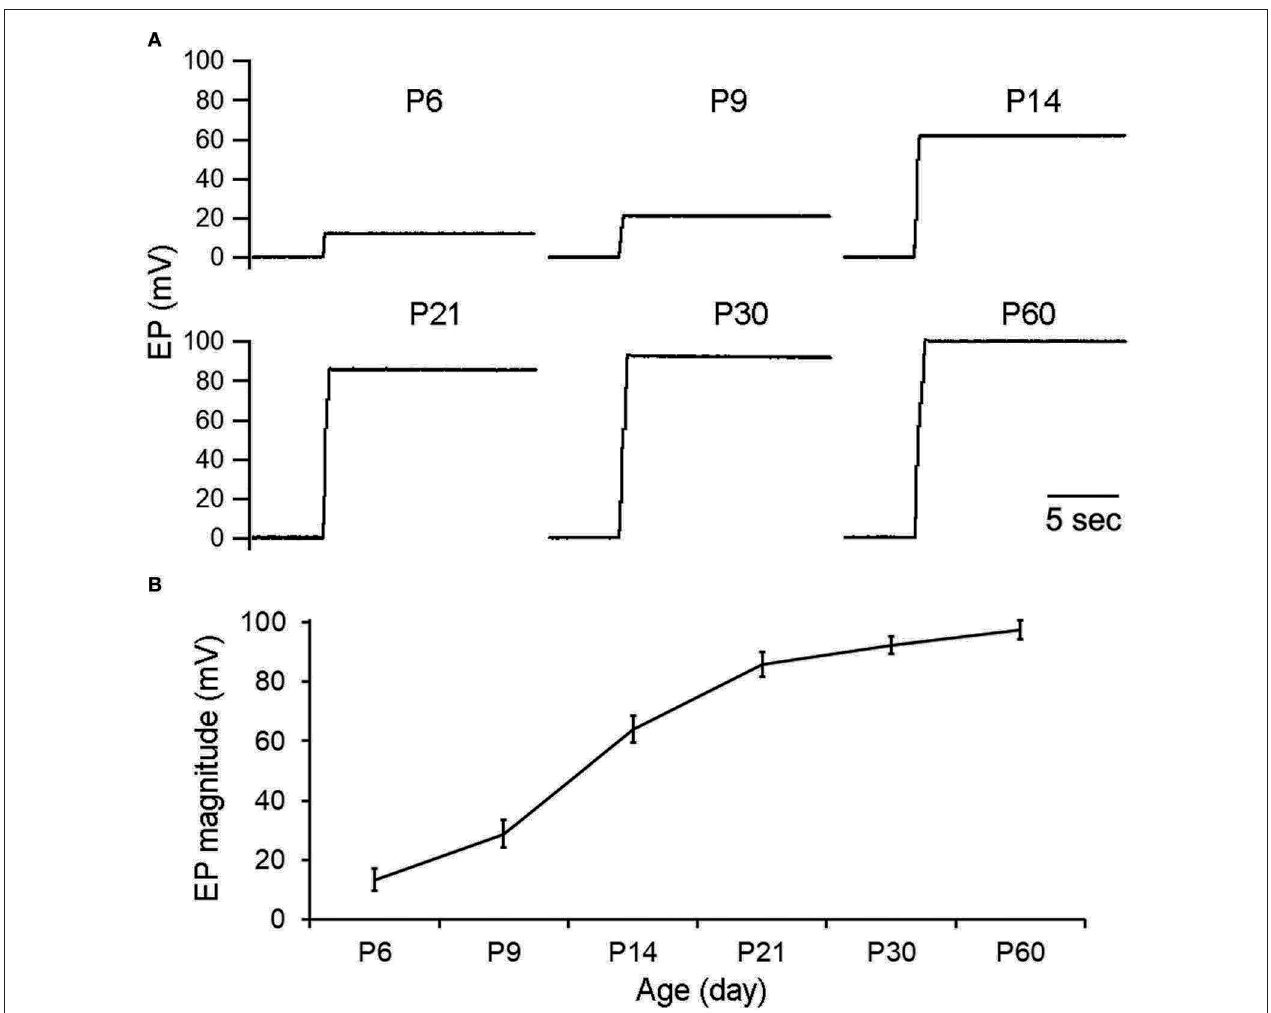
FIGURE 2 | EP during development. (A) Representative examples of EP recorded from cochlear basal turn during development. Age is shown on top of each recording/panel. (B) Mean and SD of EP during development ( n = 8 for each age